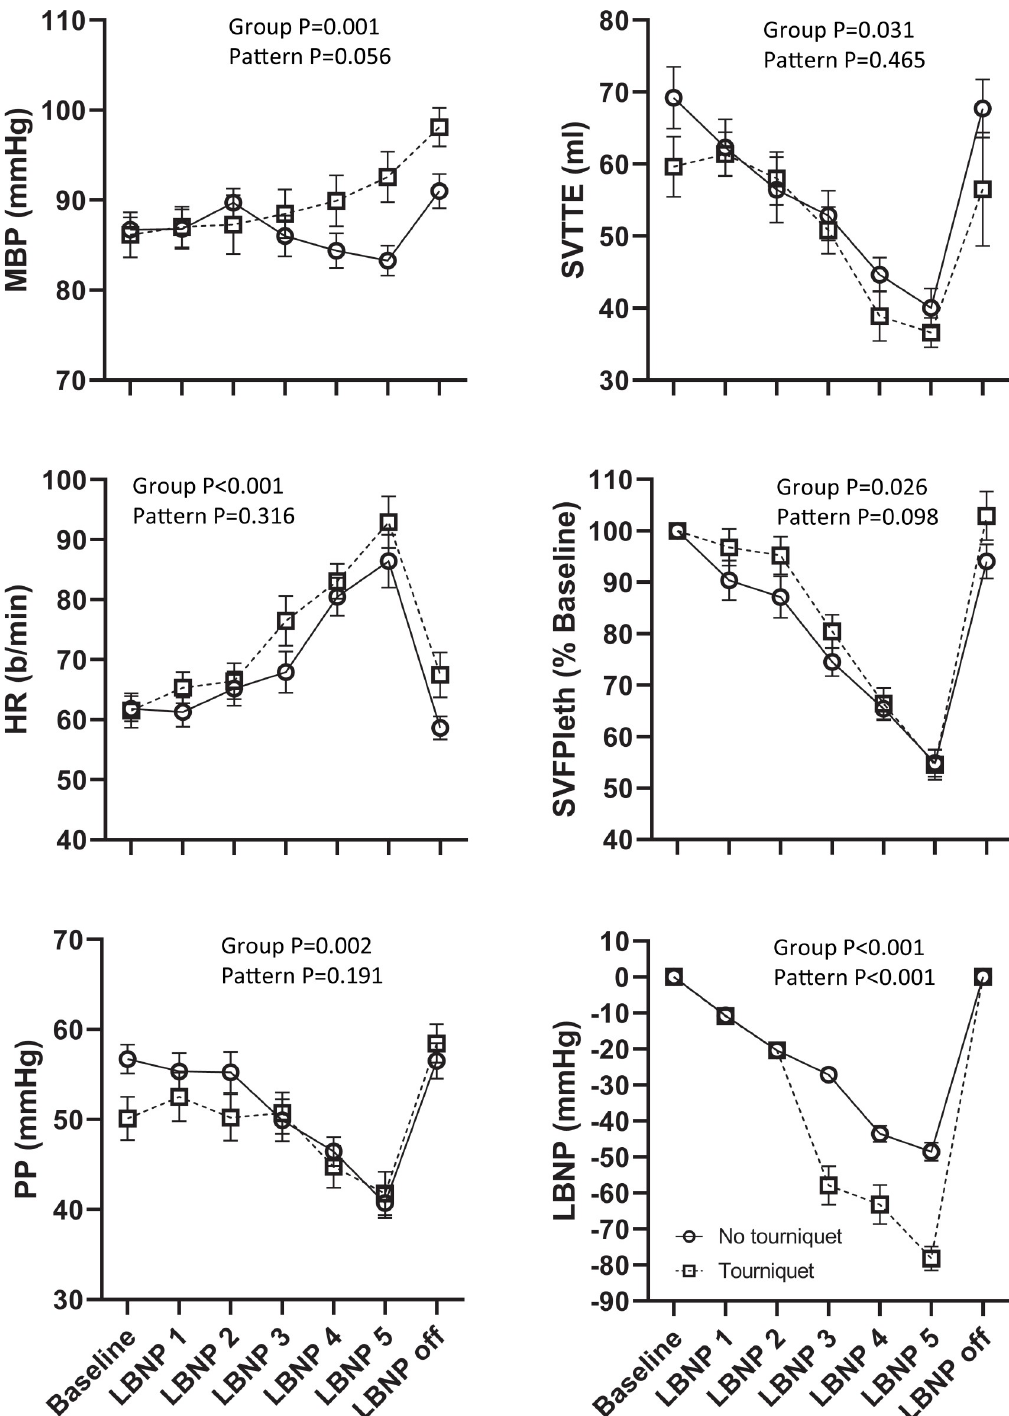
Fig 1. Cardiovascular response to progressive LBNP. Effects of progressive LBNP (-10, -20 mmHg, then titrated to target SV FPleth , stroke volume measured by finger Plethysmography, of 80, 65–70 and 55–64% baseline SV FPleth , LBNP1-5 respectively) on mean arterial blood pressure (MBP), heart rate (HR), arterial pulse pressure (PP), stroke volume measured by trans-thoracic echo (SV TTE ). Data presented as mean ± SEM. p values indicated on each panel show probability of differences between groups, and differences in the pattern of changes, being due to chance (ANOVA). Changes over time were statistically significant (p < 0.001) for each